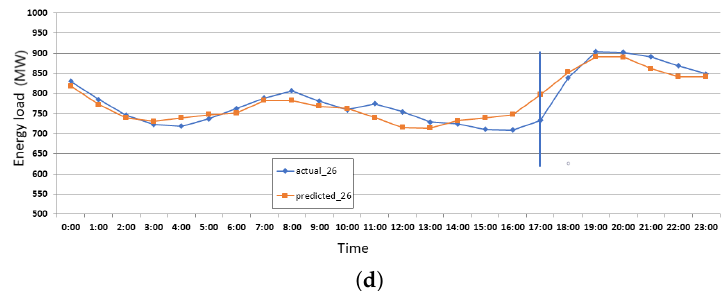
Figure 7. Highest errors recorded on the Saturdays in the month of January. ( a ) Saturday, 5 January 2019; ( b ) Saturday, 12 January 2019; ( c ) Saturday, 19 January 2019; ( d ) Saturday, 26 January 2019. Figure 8 represents energy consumption on Sundays in Jan 2019, which occurred on the 6th, 13th, 20th, and 27th of that month.The X-axis represents the time of day in hours and the Y-axis shows the energy consumption load.